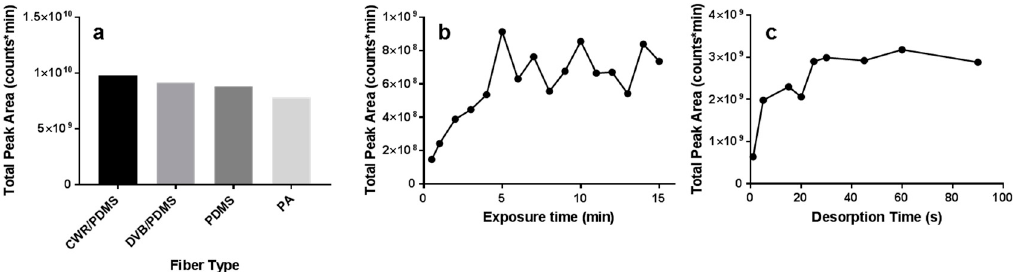
Figure 1. ( a ) Arrow fiber performance based on total summed peak area of all compounds in the volatiles reference mix (VRM) 1 and the commercial saturated alkanes mix (SAM C ). ( b ) Total peak area measured for carbon wide range (CWR)/polydimethylsiloxane (PDMS) Arrow at different exposure times to VRM 2 and SAM 2. ( c ) Total peak area measured for CWR/PDMS Arrow at 5 min exposure time and varied desorption times after saturation in VRM 1 and SAM 1.